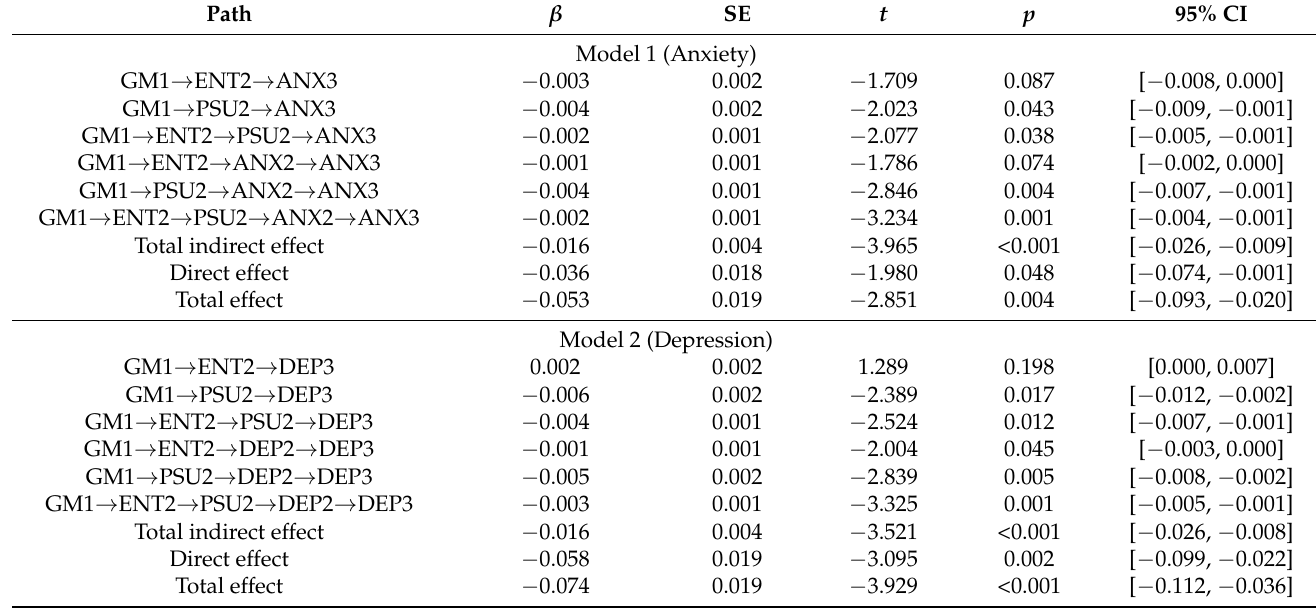
Table 3. Bias-corrected bootstrap test results on the mediating